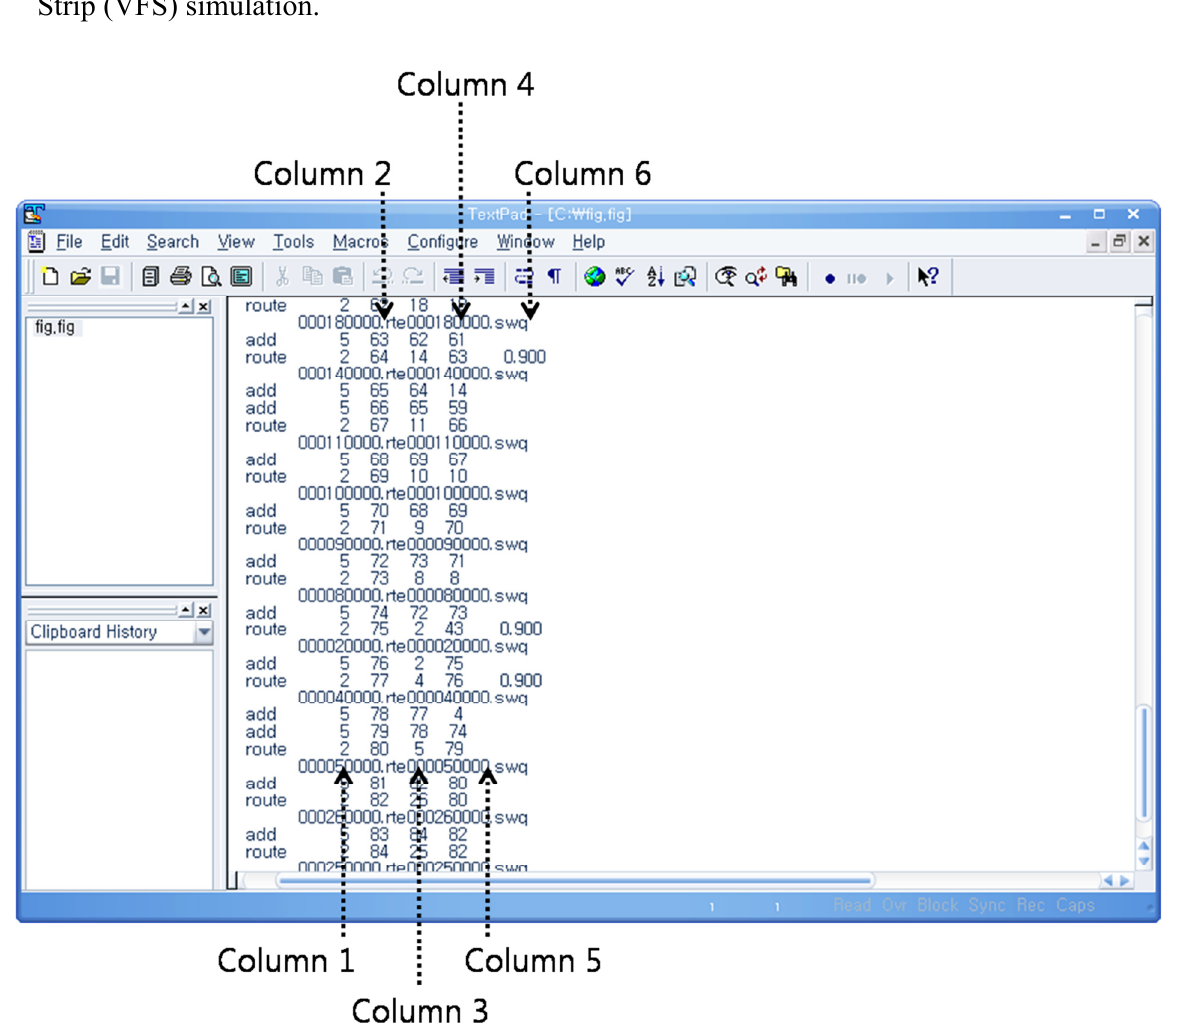
Figure 2. Revision of SWAT configuration file for diversion channel and Vegetative Filter Strip (VFS)